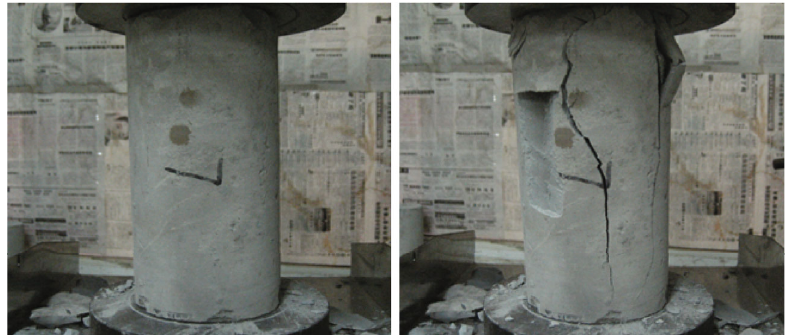
Figure 9: Uniaxial compressive strength test.